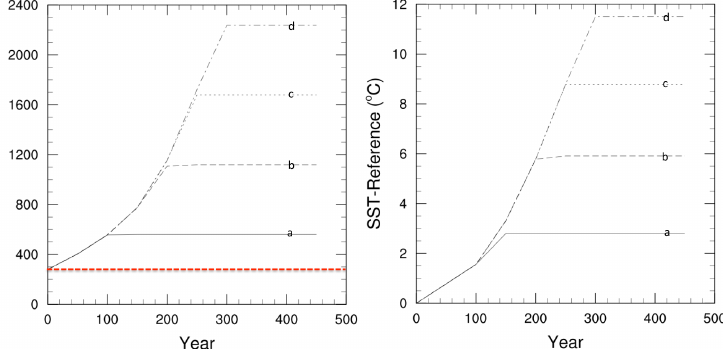
Figure 1. Atmospheric p CO 2 (left panel) and sea surface temperature (right panel) increase from the reference run: 2 × CO 2 (a), 4 × CO 2 (b), 6 × CO 2 (c), and 8 × CO 2 (d) for the first 500 years of a 30kyr simulation. The red dashed line indicates the preindustrial p CO 2